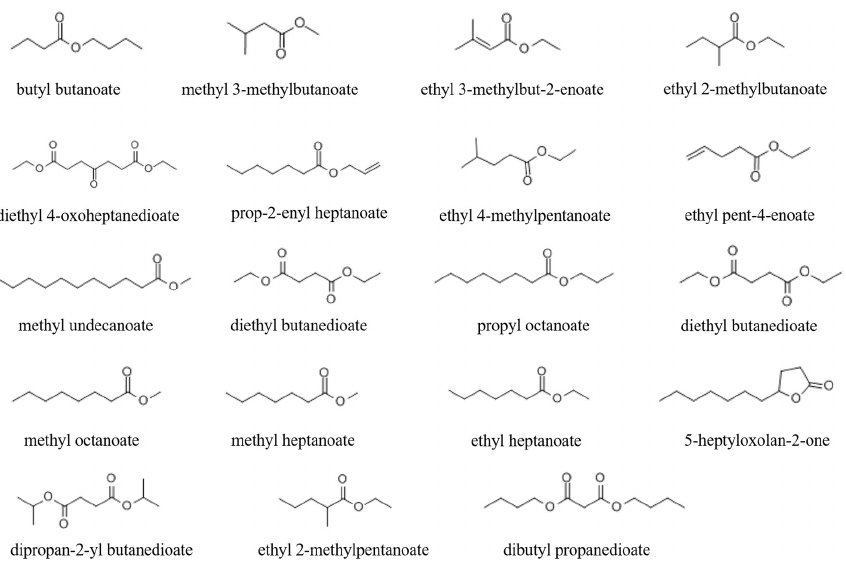
Figure 2. The structure of nematicidal volatile esters. Table 2. The mortality of M. javanica treated with 10 VOCs (10 µ L) produced by B. diminuta . Mortality of M. javanica (%) ± Compounds